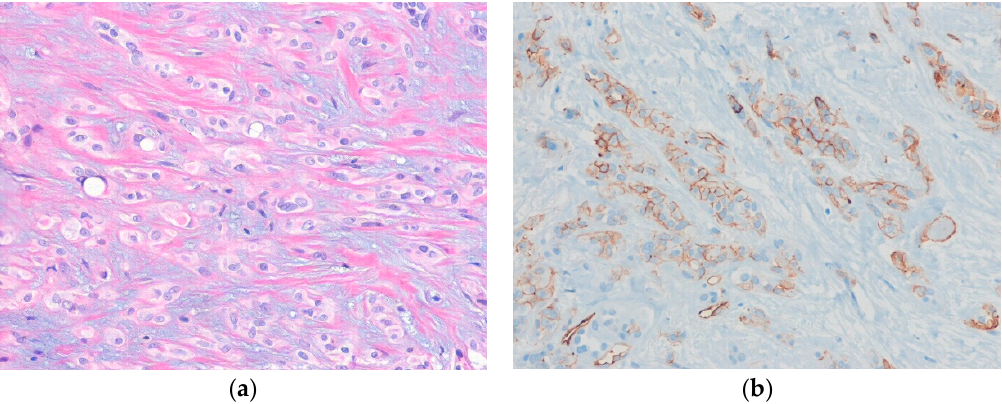
Figure 3. Epithelioid hemangioendothelioma. ( a ) The tumor cells of epithelioid hemangioendothelioma are arranged in trabecular or cord-like patterns in a myxohyaline stroma. Occasional intracytoplasmic vacuoles are present; ( b ) The tumor cells are positive for CD31 (H&E stain, original magnification 200× ( a ); CD31 immunostain, original magnification 200× ( b )). The differential diagnoses of epithelioid hemangioendothelioma include epithelioid angiosarcoma, epithelioid sarcoma, and metastatic carcinomas. Epithelioid angiosarcomas show more cytologic atypia than epithelioid hemangioendotheliomas and are negative for CAMTA1. Epithelioid sarcomas lack intracytoplasmic vacuoles and do not express SMARCB1 (INI1). Metastatic